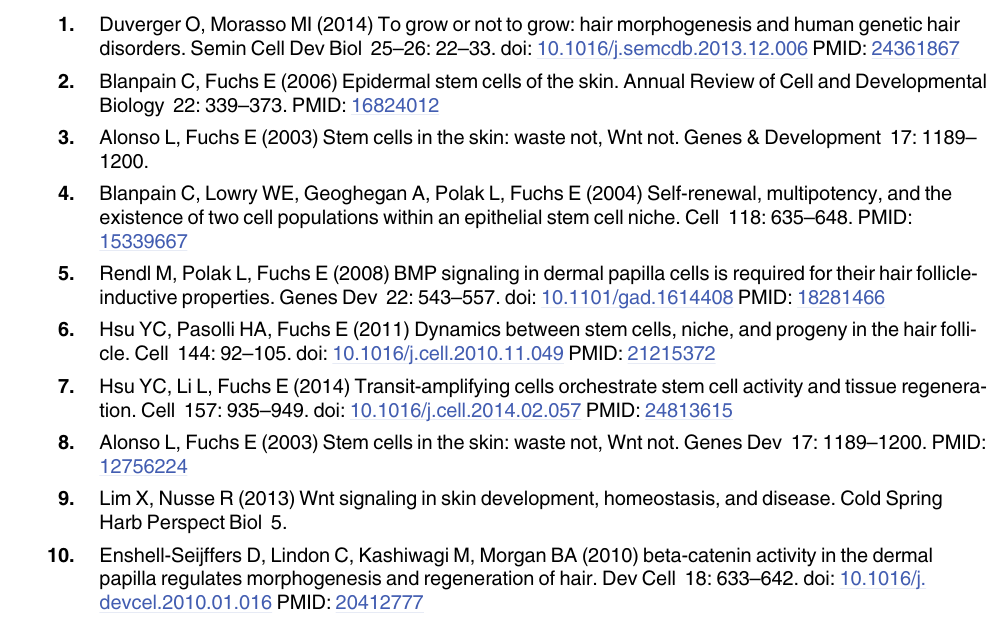
S3 Fig. Ablation of Foxp1 shortens anagen duration during hair cycling. A: A dorsal view showed a sign of hair shedding in the K14-Cre; Foxp1 fl/fl ( cKO ) mice at p29. B: Lengths of hair shafts plucked from the cKO mice at P47 were shorter than those of the WT (n = 4). (cid:3) , p < 0.05. C: HE staining for the first and second hair cycles in the WT and cKO mice at P45 to P55. D: A dorsal view for the first and second hair cycles in the WT and cKO mice from P22 to P55. E: The cKO mutant mice displayed shorter durations of telogen and anagen than WT controls fol- lowing the first hair cycle. (TIF) S4 Fig. TUNEL staining for the HaCat cells treated with one-hour stimulation of 500 μ M O . The TUNEL staining was performed in HaCat cells following one-hour stimulation H 2 2 O . with 500 μ M H 2 2 S1 Table. Primers of qRT-PCR. Primers were designed for